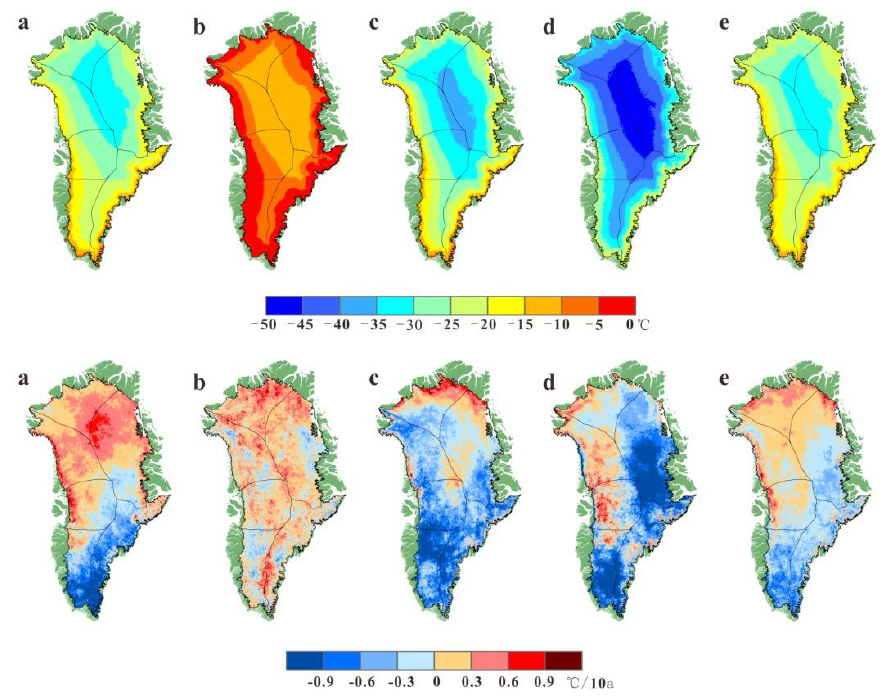
Figure 3. Seasonal LST and LST trend over the GrIS in Spring ( a ), Summer ( b ), Autumn ( c ) and Winter ( d ) and the mean Annual results ( e ) from March 2000 to December 2020. Obviously, the spatial pattern of surface-temperature changes in the GrIS is different, as with the change of season, the GrIS LST-change trend has a great spatial difference. The LST increases mainly in spring and summer, and decreases in autumn and winter. The variation trend of LST in spring and autumn varies greatly from north to south, and from east to west in winter. Meanwhile, the NO is the region with the strongest warming, while SE and SW are the region with the highest temperature but which experienced the most common cooling, showing obvious cooling except in summer.